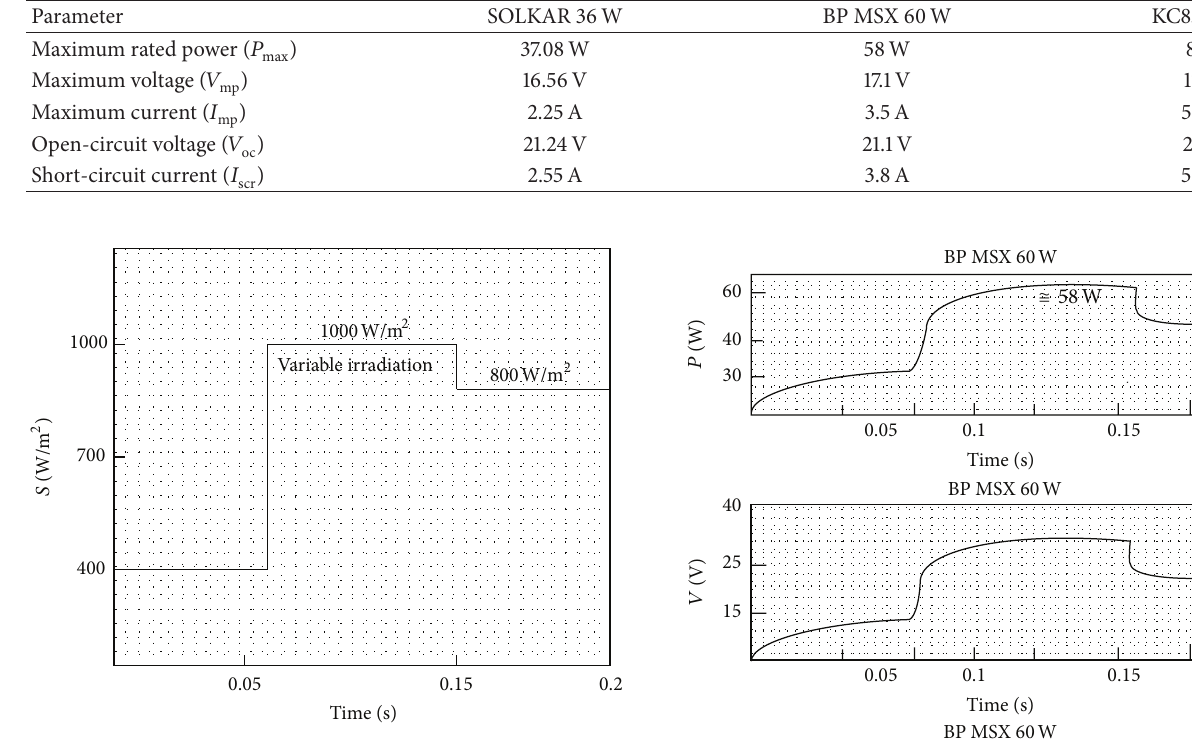
Figure 20: Variable irradiation with respect to time to observe the tracking capability.